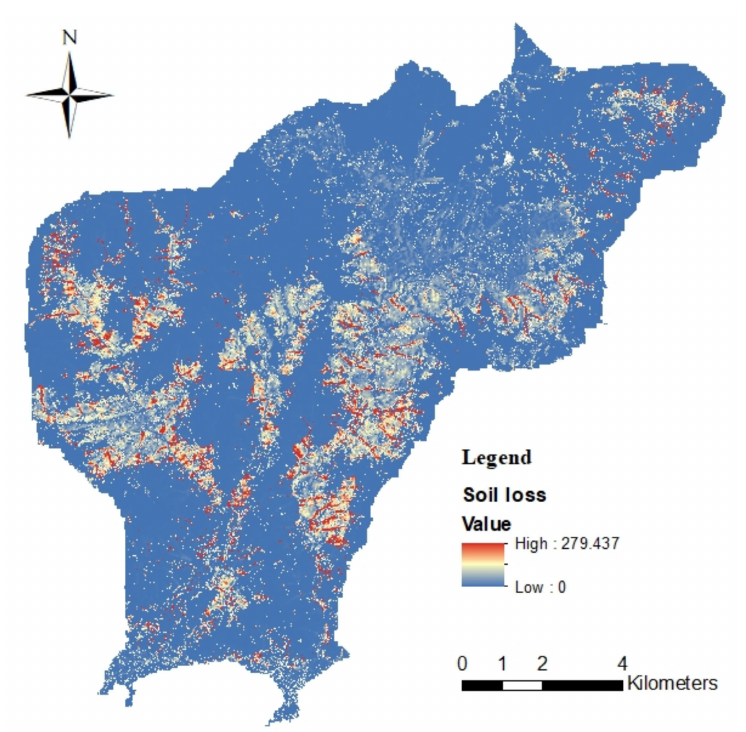
Figure 20. Soil loss map with R-factor values derived from in situ data and C-factor values derived from literature